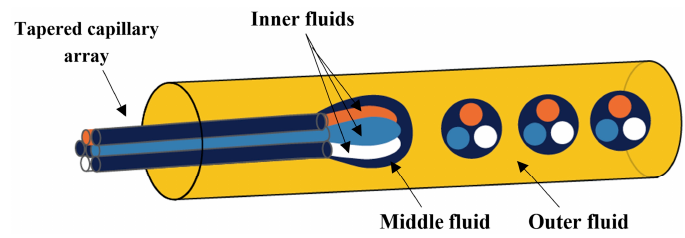
Figure 22. A tapered array of seven glass capillaries inserted into a collection capillary. The three distinct inner aqueous phases were delivered through nonadjacent peripheral capillaries [145].